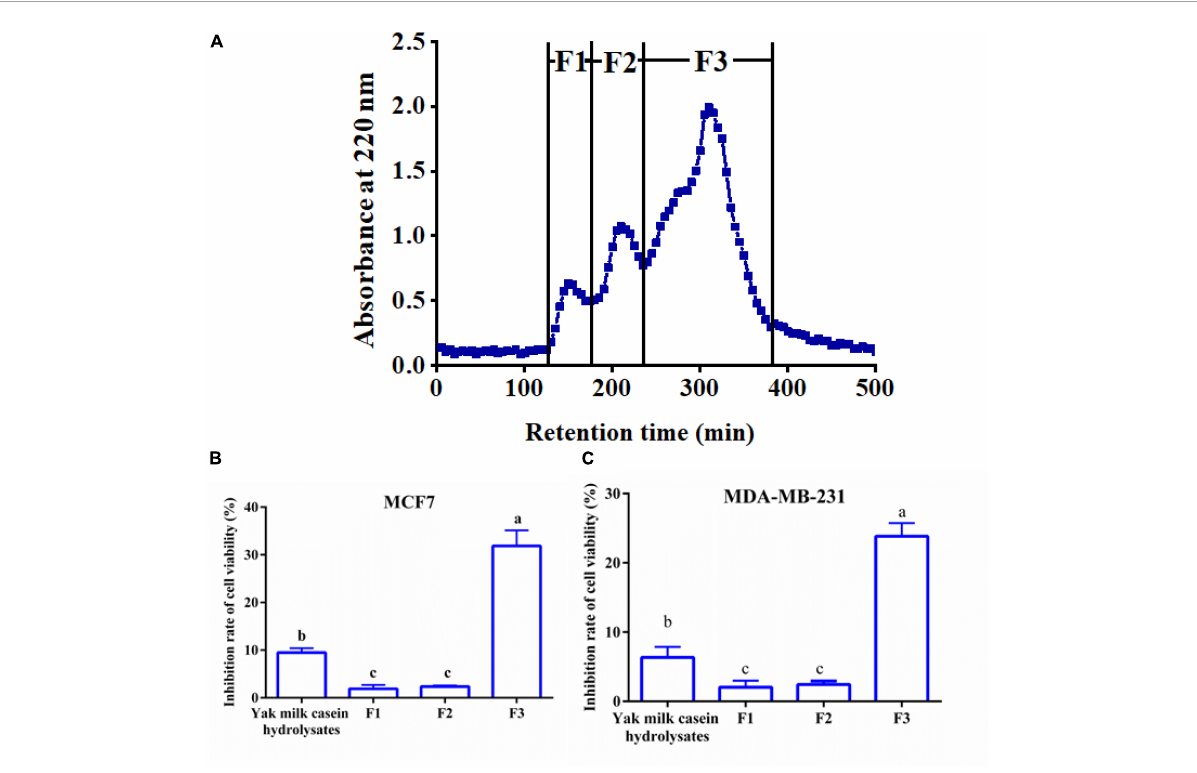
FIGURE2 Elution profile (A) and anti-breast cancer cells activity (B,C) of yak milk casein hydrolysates (YMCH) fractions separated using a Sephadex G-25 gel column. The final dose of various YMCH was 0.1 mg/mL, the treatment time was 48